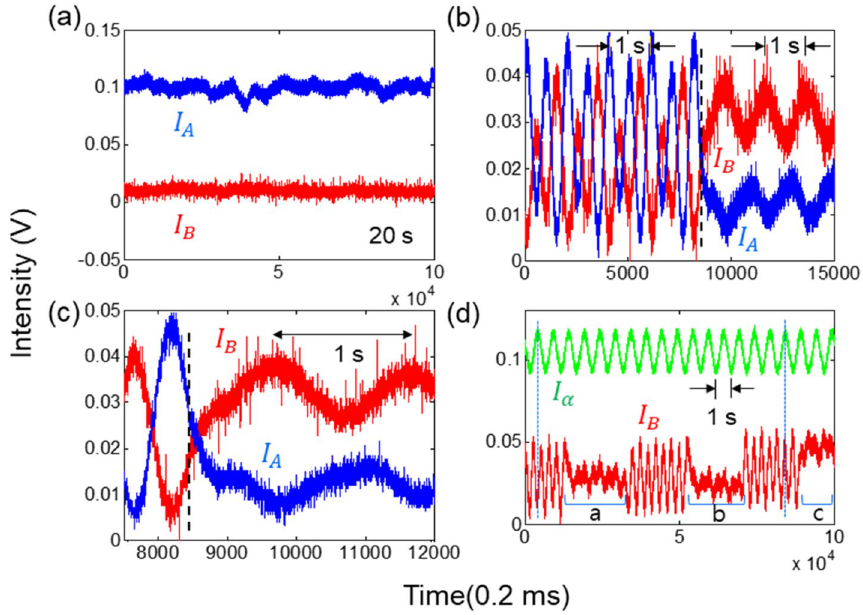
ϕ 12 . ( b ) Switching between CBW and USCKD. = 1 Hz after the dashed line. The value of vertical axis is ψ 12 = =